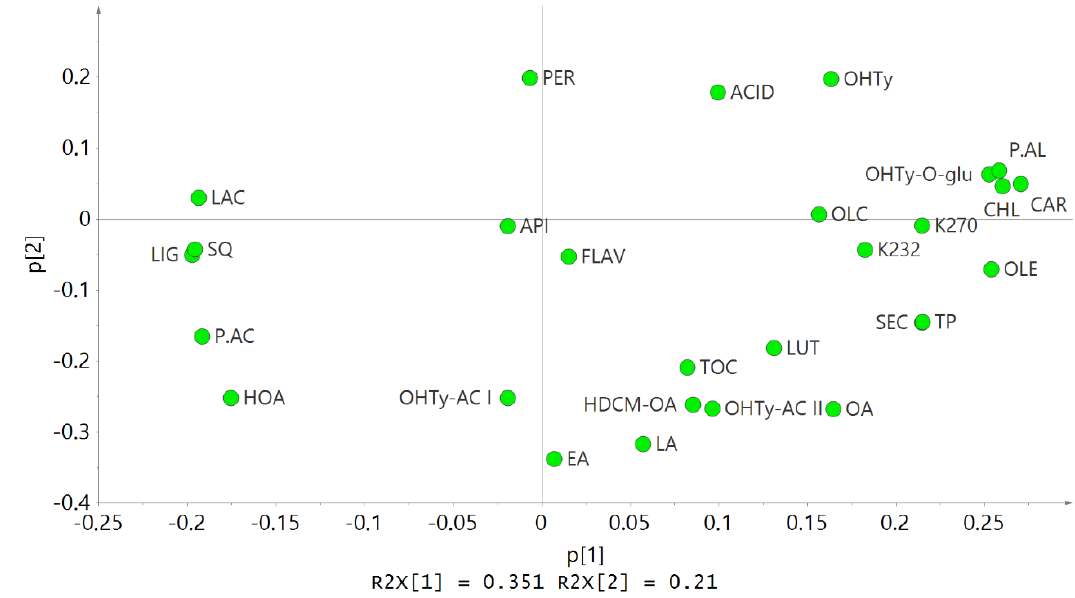
Figure 2. Loading scatter plot showing the distribution of the different parameters analyzed in the EVOO samples. PER: Peroxide value; ACID: Acidity; CAR: Carotenes; CHL: Chlorophylls; TOC: Tocopherols; SQ: Squalene; TP: Total phenols; SEC: Secoiridoids; LIG: Lignans; FLAV: Flavones; P.AL: Phenolic alcohols; P.AC: Phenolic acids; API: Apigenin; LUT: Luteolin; LAC: Lactone; EA: Elenolic acid; OHTy: Hydroxytyrosol; OHTy-AC I, -AC II: Hydroxytyrosol acetate; OHTy-O-glu: Hydroxytyrosol-O-glucoside; HOA: Hydroxyoleuropein algycone; HDCM-OA: Hydroxydecarboxymethyl oleuropein aglycone; OA: Oleuropein aglycone; LA: Ligstroside aglycone; OLE: Oleacein; OLC: Oleocanthal.